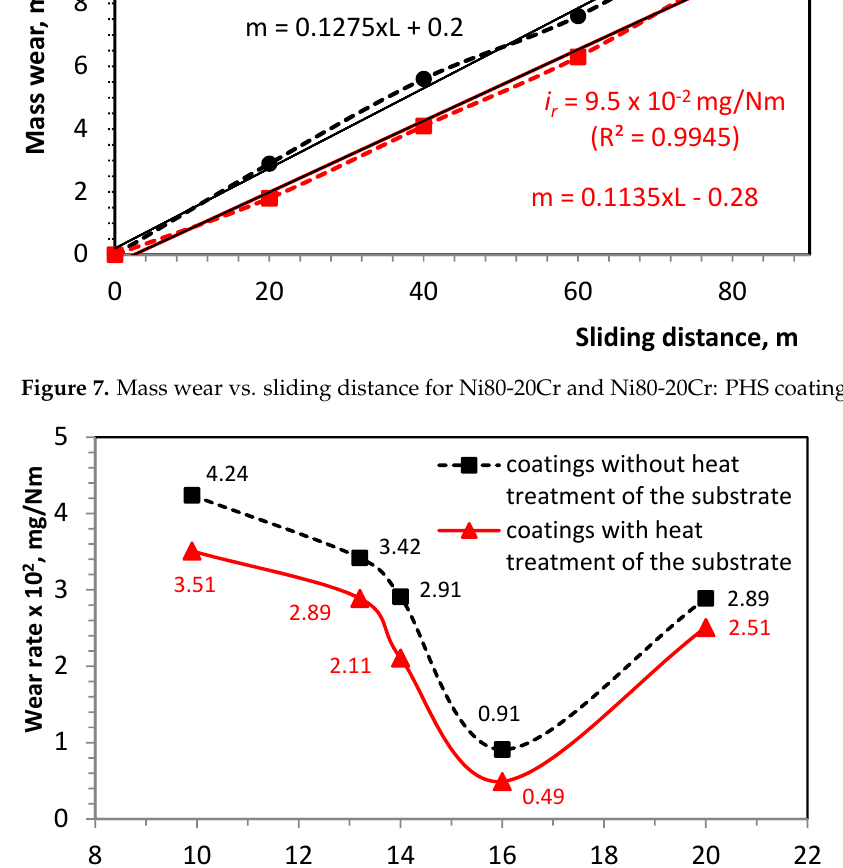
Figure 6. Mass wear vs. sliding distance for NiBSi-16Cr and NiBSi-16Cr: PHS coatings. Figure 7. Mass wear vs. sliding distance for Ni80-20Cr and Ni80-20Cr: PHS coatings. Figure 8 represents graphically the dependence of the wear rate on the concentration